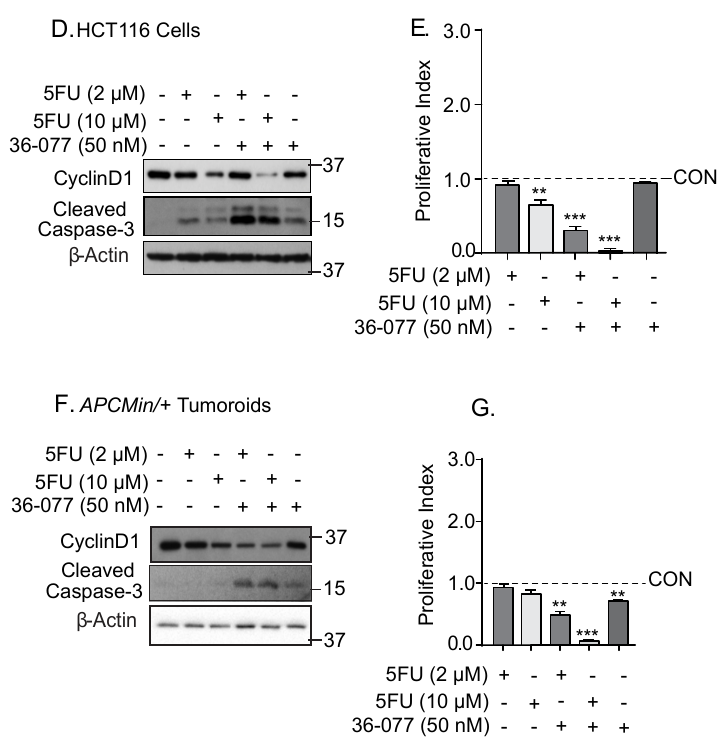
Figure 4. Combination treatment of 36-077 and 5-FU synergizes to inhibit colon cancer cell survival. Caco-2 and HCT116 cells were treated with 5-FU with or without 36-077 for 24 h. ( A ) Cell death was analyzed using cell viability assay. Effects of 5-FU and 36-077 alone, and in combination (HCT116 cells); ( B – G ) immunoblotting using total cell lysates from control and treated cells, and densitometry analysis. Caco-2 and HCT116 cells and colon tumoroids were used. Proliferative index was determined by calculating the ratio of cyclin-D1 and cleaved caspase-3 expression. Statistical significance was determined by 1-way ANOVA. Statistical significance was determined by Student’s t -test. *** p < 0.001 and ** p <